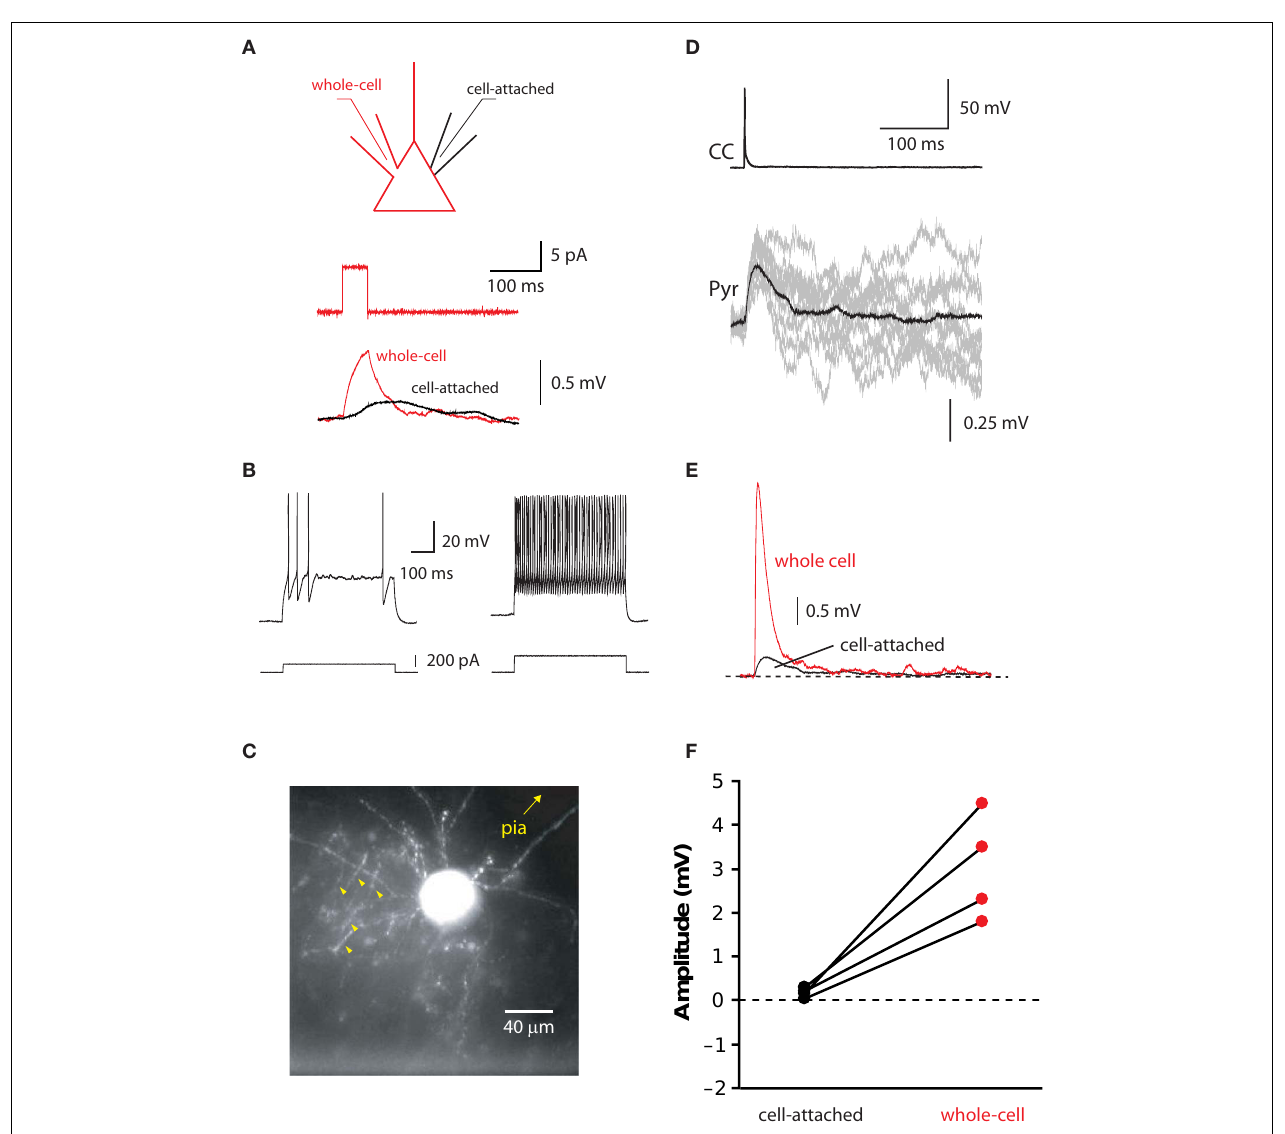
FIGURE 4 | Depolarizing effect of chandelier neurons, in cell-attached recordings. (A) Schematic of recording confi guration ( top ) and traces illustrating cell-attached recording of small membrane potential fl uctuations ( bottom ) (B–E) Physiologically (B) and anatomically (C) identifi ed chandelier cell